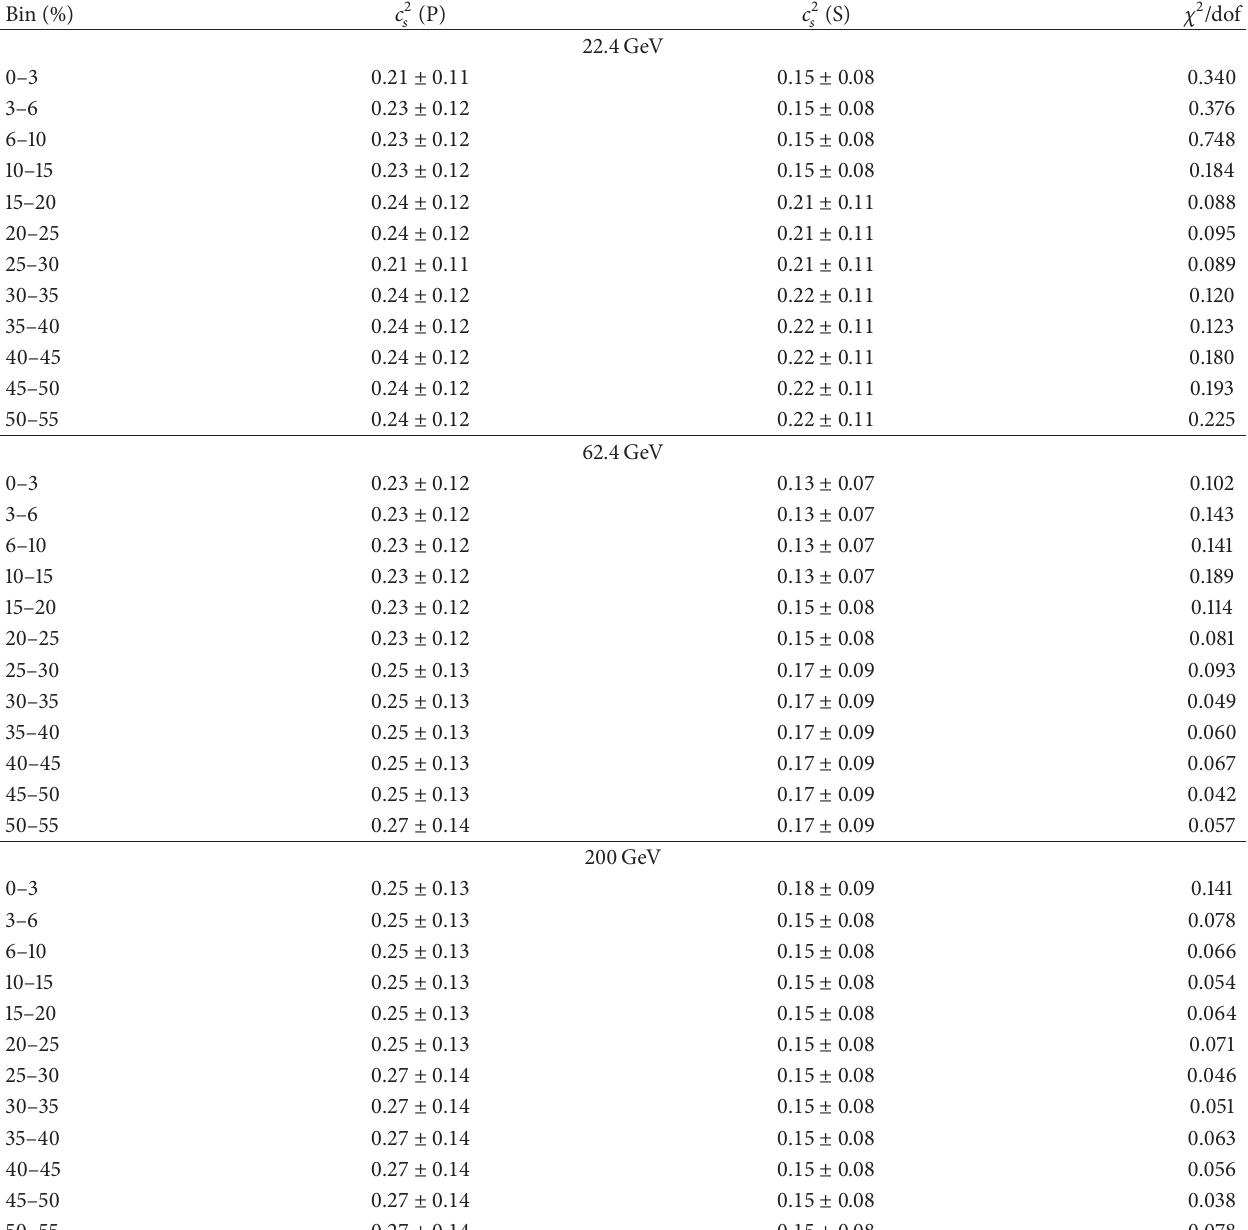
Table 2: Values of 𝑐 2 𝑠 for the participants and spectators as well as 𝜒 2 /dof for the curves in Figures 5–7 which represent Cu-Cu collisions at RHIC energies.